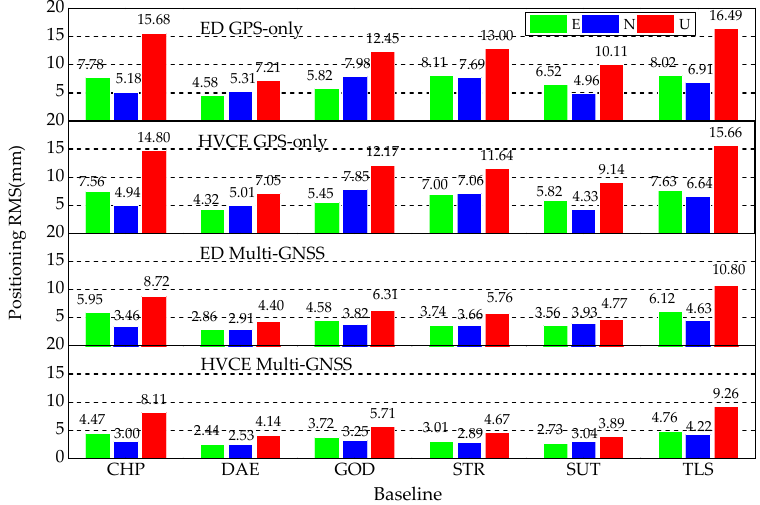
Figure 6. Time series of kinematic positioning errors of east ( top ), north ( middle ) and up ( bottom ) components for baseline SUT from DoY 183 to 186 in 2019. The reset appearing in the start of each day is caused by the independent daily process.